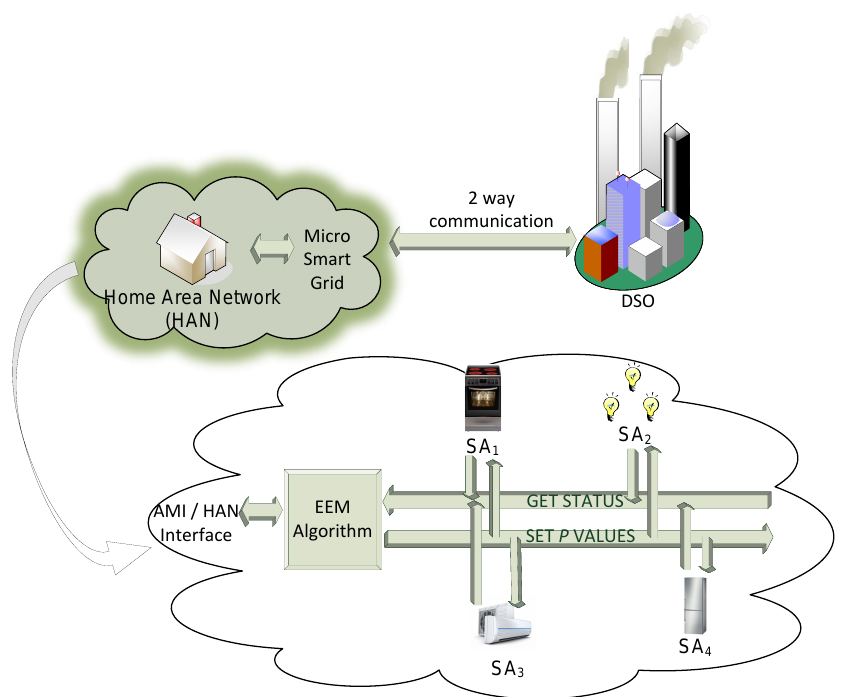
Figure 3. Illustration of data exchange between the EEM algorithm from DSO and SA in